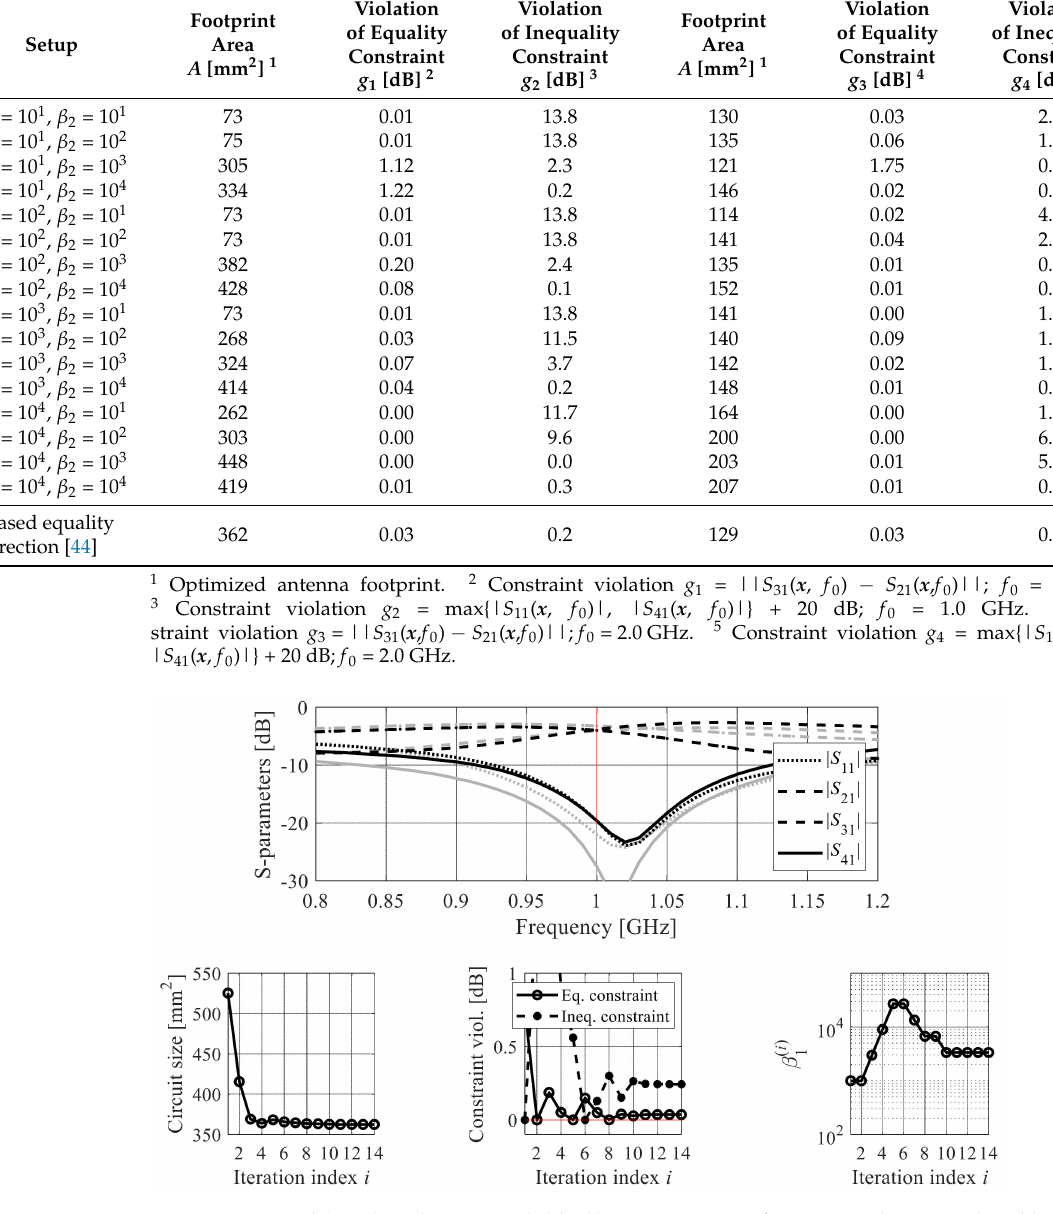
Figure 19. Initial (gray) and optimized (black) S-parameters of Circuit I. The vertical and horizontal lines mark the target operating bandwidth and the acceptance level for the matching | S 11 | and isolation | S 41 | responses. Additionally, shown is the evolution of the circuit size and constraint violations (in case of feasibility, violations shown as zero), as well as evolution of the penalty coefficient for the inequality constraint. The vertical line shows the target operating frequency of 1.0